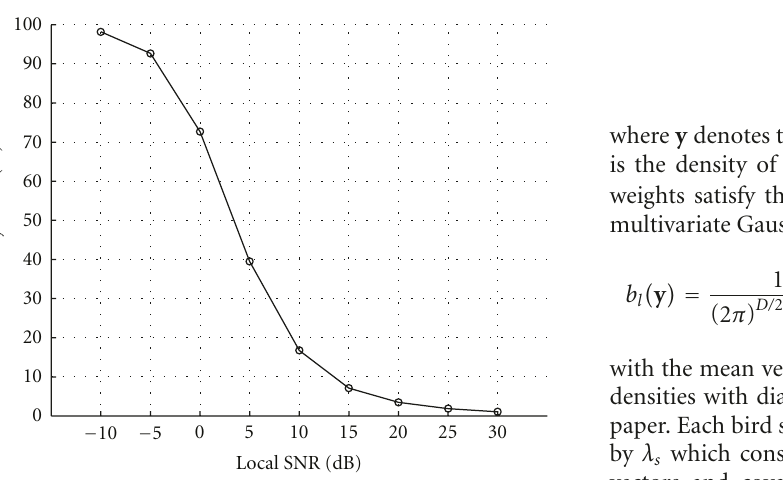
Figure 4: False-rejection error rate of bird tonal spectral points detection in White noise conditions as a function of the local SNR when the false-acceptance error was kept at